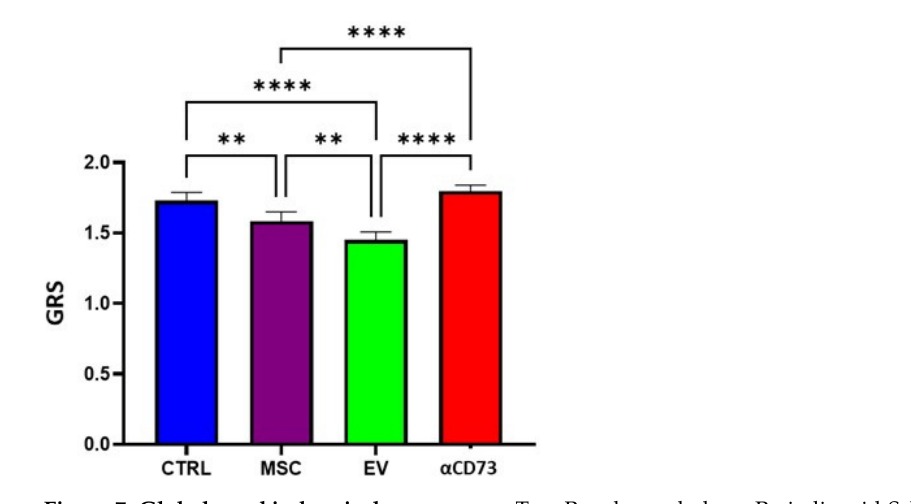
Figure 7. Global renal ischemic damage score. Top: Renal morphology. Periodic acid-Schiff staining of representative renal sections from the CTRL, MSC, EV, and α CD73 groups (at × 10 magnification). Bottom: Columns representing the global ischemic damage score (GRS) expressed as mean and 95% confidence interval (** p < 0.01; **** p < 0.0001). CTRL, control group; MSC, mesenchymal stromal cell group; EV, extracellular vesicle group; α CD73, CD73-silenced group. N = 20 sections from each kidney were analyzed.